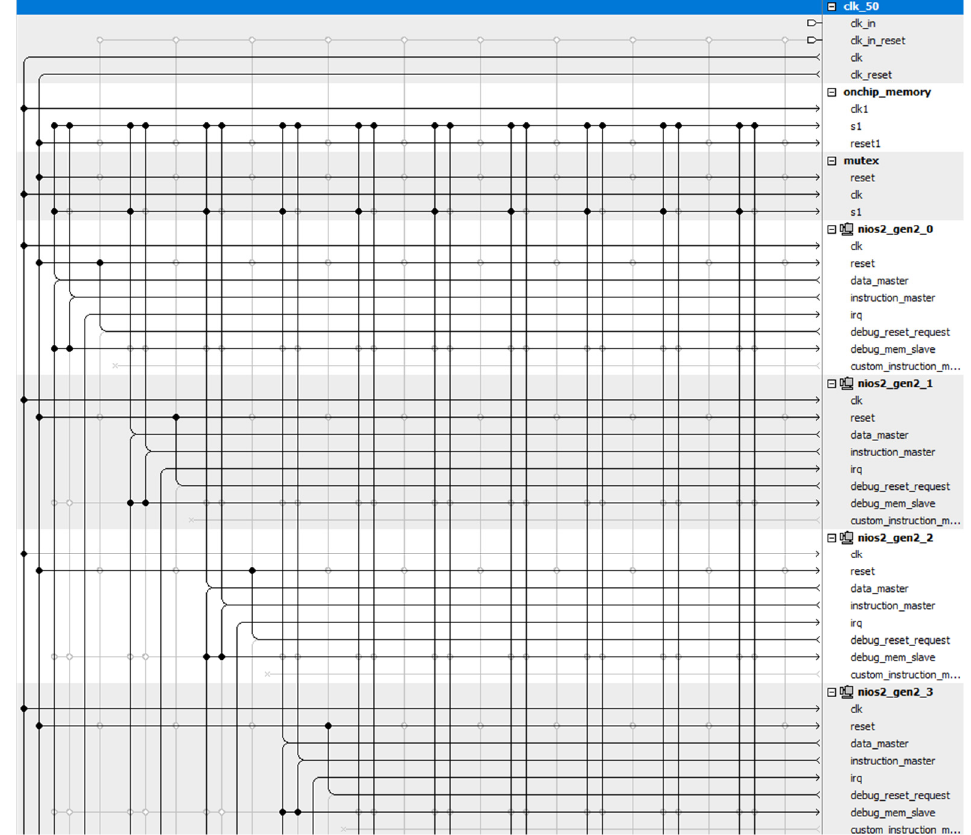
Figure 13. A snapshot for the bus connections of a 10-core system.